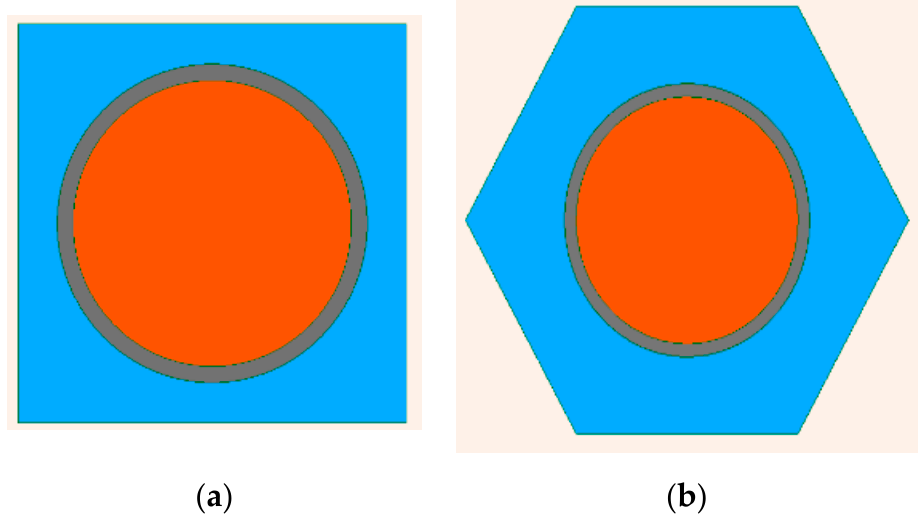
Figure 7. PWR and VVER Cell cases. ( a ) PWR UOX or MOX Cell. Fuel: UOX or MOX; ( b ) hexagonal UOX Cell. Fuel: UOX.